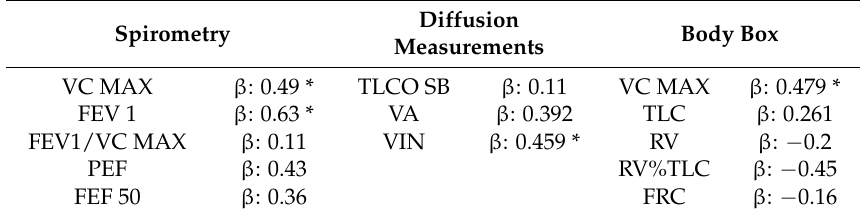
Table 2. Association of serum totalTEQ (PCDD/F+dl-PCBs) (pg/g fat) with lung function parameters. Diffusion Spirometry